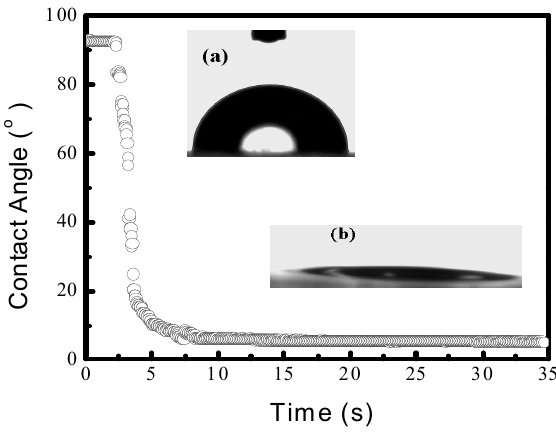
Figure 3. Contact angles of water on stimulus-responsive PS– b –PAA microporous films as a function of time. Insets are water droplet profiles on the stimulus-responsive PS– b –PAA microporous films in different stages: ( a ) represents a typical droplet profile in the initial stage, whereas ( b ) is a representative profile with PAA chains covering the surface stage.